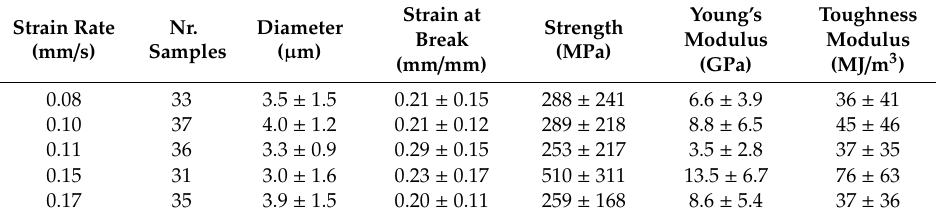
Figure 1. Mechanical properties of the spider silk of Cupiennius salei at different strain rates: ( a ) strain at break, ( b ) strength, ( c ) Young’s modulus, and ( d ) toughness modulus. Table 2. Mechanical properties of the dragline silk at different strain rates.